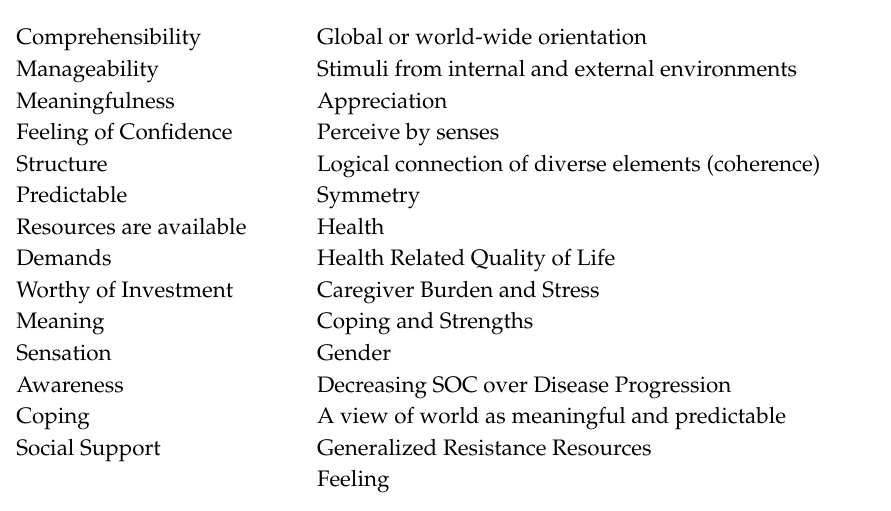
List A: Frequently Recurring Terms from Definitions and Review of the Literature including Sense of Coherence (SOC), Sense, and